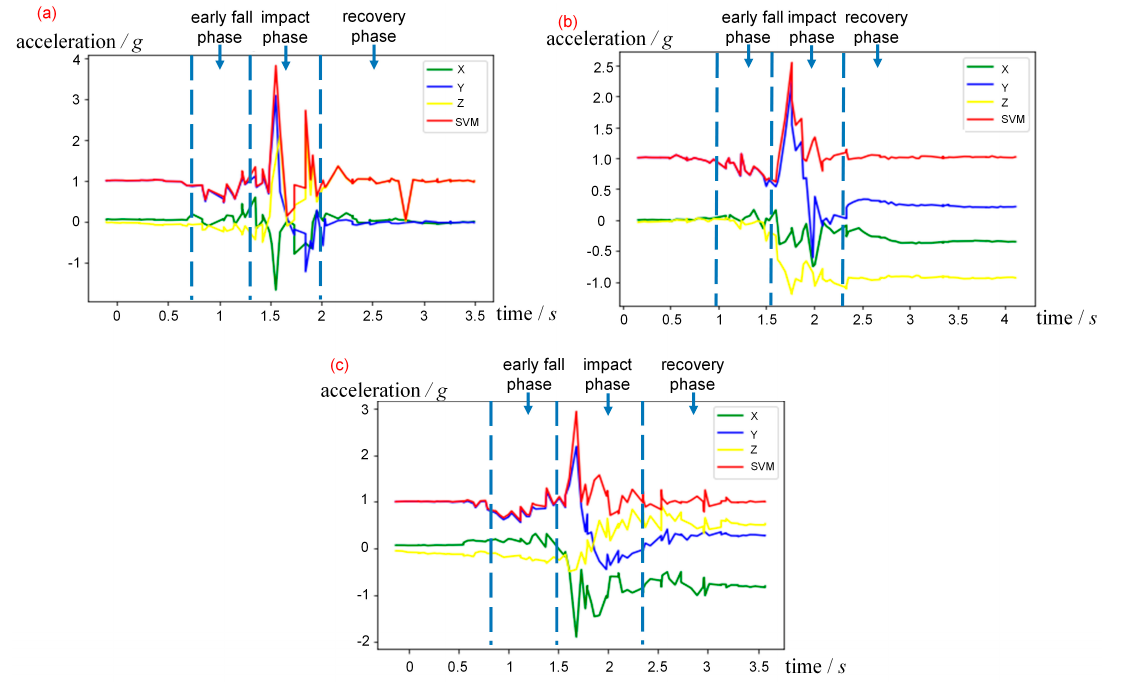
Figure 2. The acceleration data of the complete falling action. The x, y, z, and SVM labels represent x-axis, y-axis, z-axis, and sum vector magnitude of acceleration, respectively. ( a ) A fall backward sample. ( b ) A fall forward sample. ( c ) A fall laterally sample.